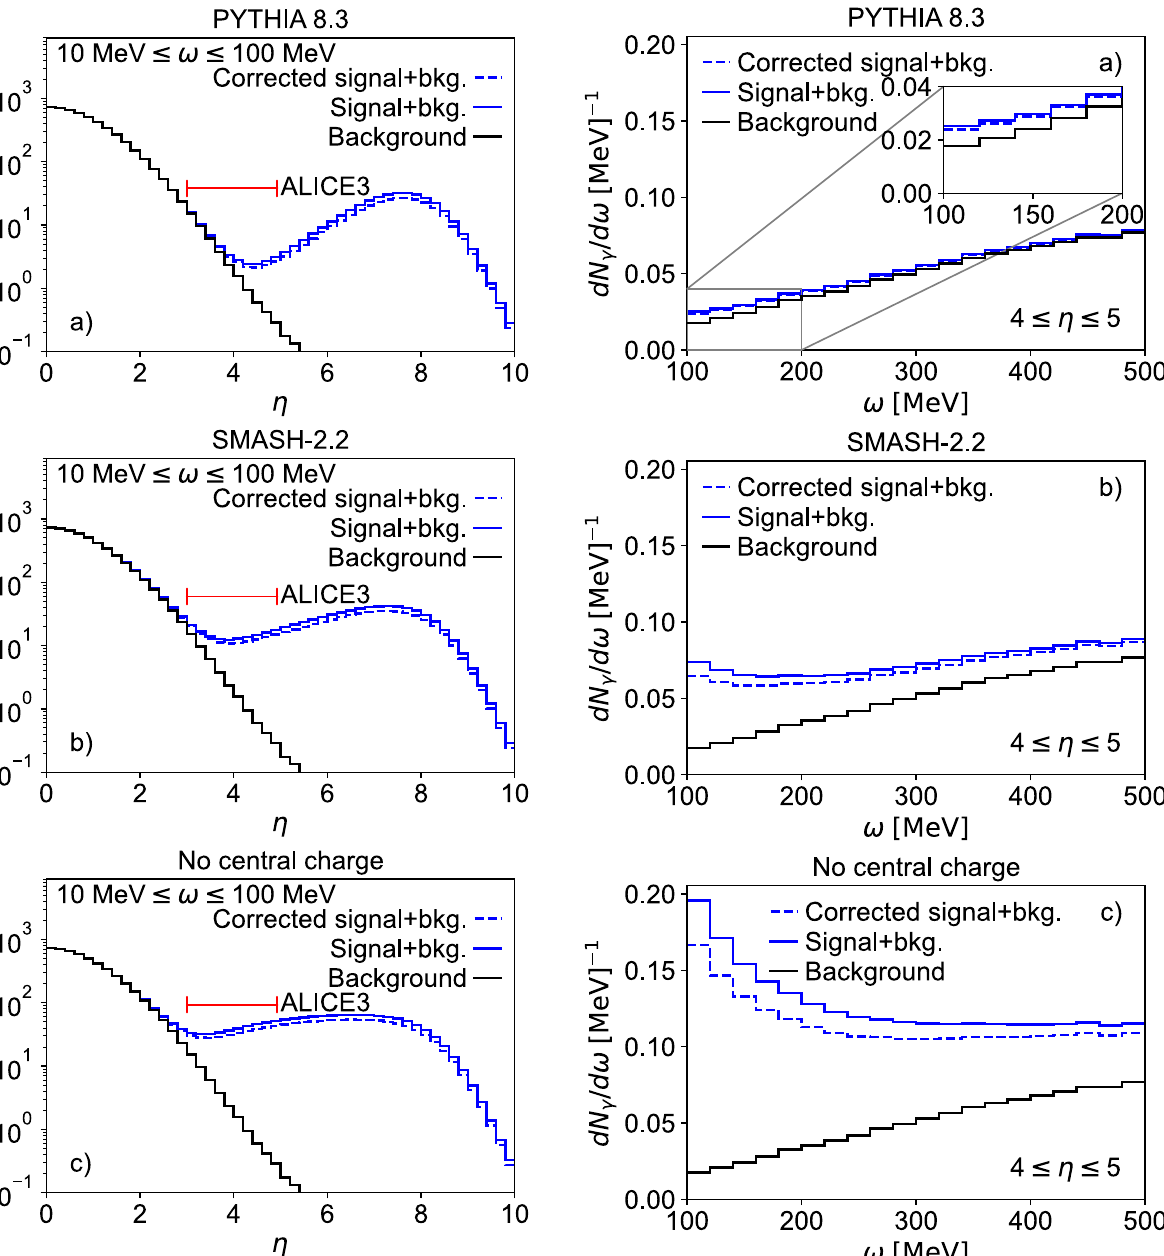
Fig. 4 Same as Fig. 3 but for photons in the energy range 0 . 01 ≤ ω ≤ 0 . 1 GeV